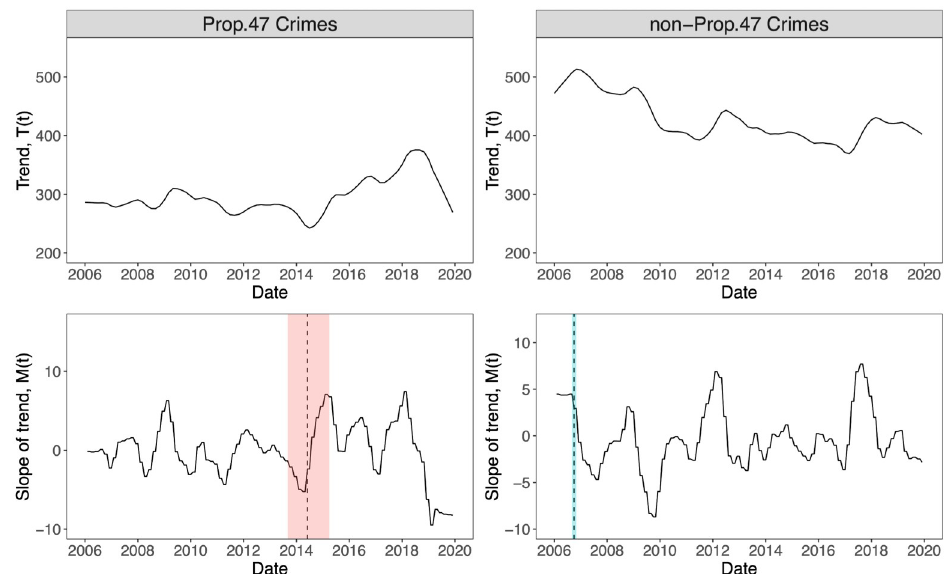
Fig 6. Change-point analysis of reported crime in Santa Monica, CA, 2006–2019. We perform our change-point analysis on the slope M ( t ) of the crime trend T ( t ) for Prop. 47 crimes (left) and non-Prop. 47 crimes (right). The top panels are the trends T ( t ) derived from raw monthly data Y ( t ) using STL decomposition with smoothing window w trend = 19 months. The lower panels visualize the slopes M ( t ), the resulting change-points, and their 95% confidence intervals. Base parameters used in the mosum change-point detection algorithm appear in the main text. The lower left panel for reclassified crimes shows a change-point in June 2014 (dotted line) with a 95% confidence interval between September 2013 and April 2015, which includes November, 2014, when Prop. 47 went into effect. This result is fairly robust to changes in the algorithm’s parameters. For non-reclassified crimes in the right panel, using our base algorithm parameters, the change-point is October 2006 (dotted line) with a 95% confidence interval between September 2006 and November 2006. However, this non-Prop. 47 change-point is strongly dependent on the algorithm parameters. No time-frame emerges that is robust to parameter changes.